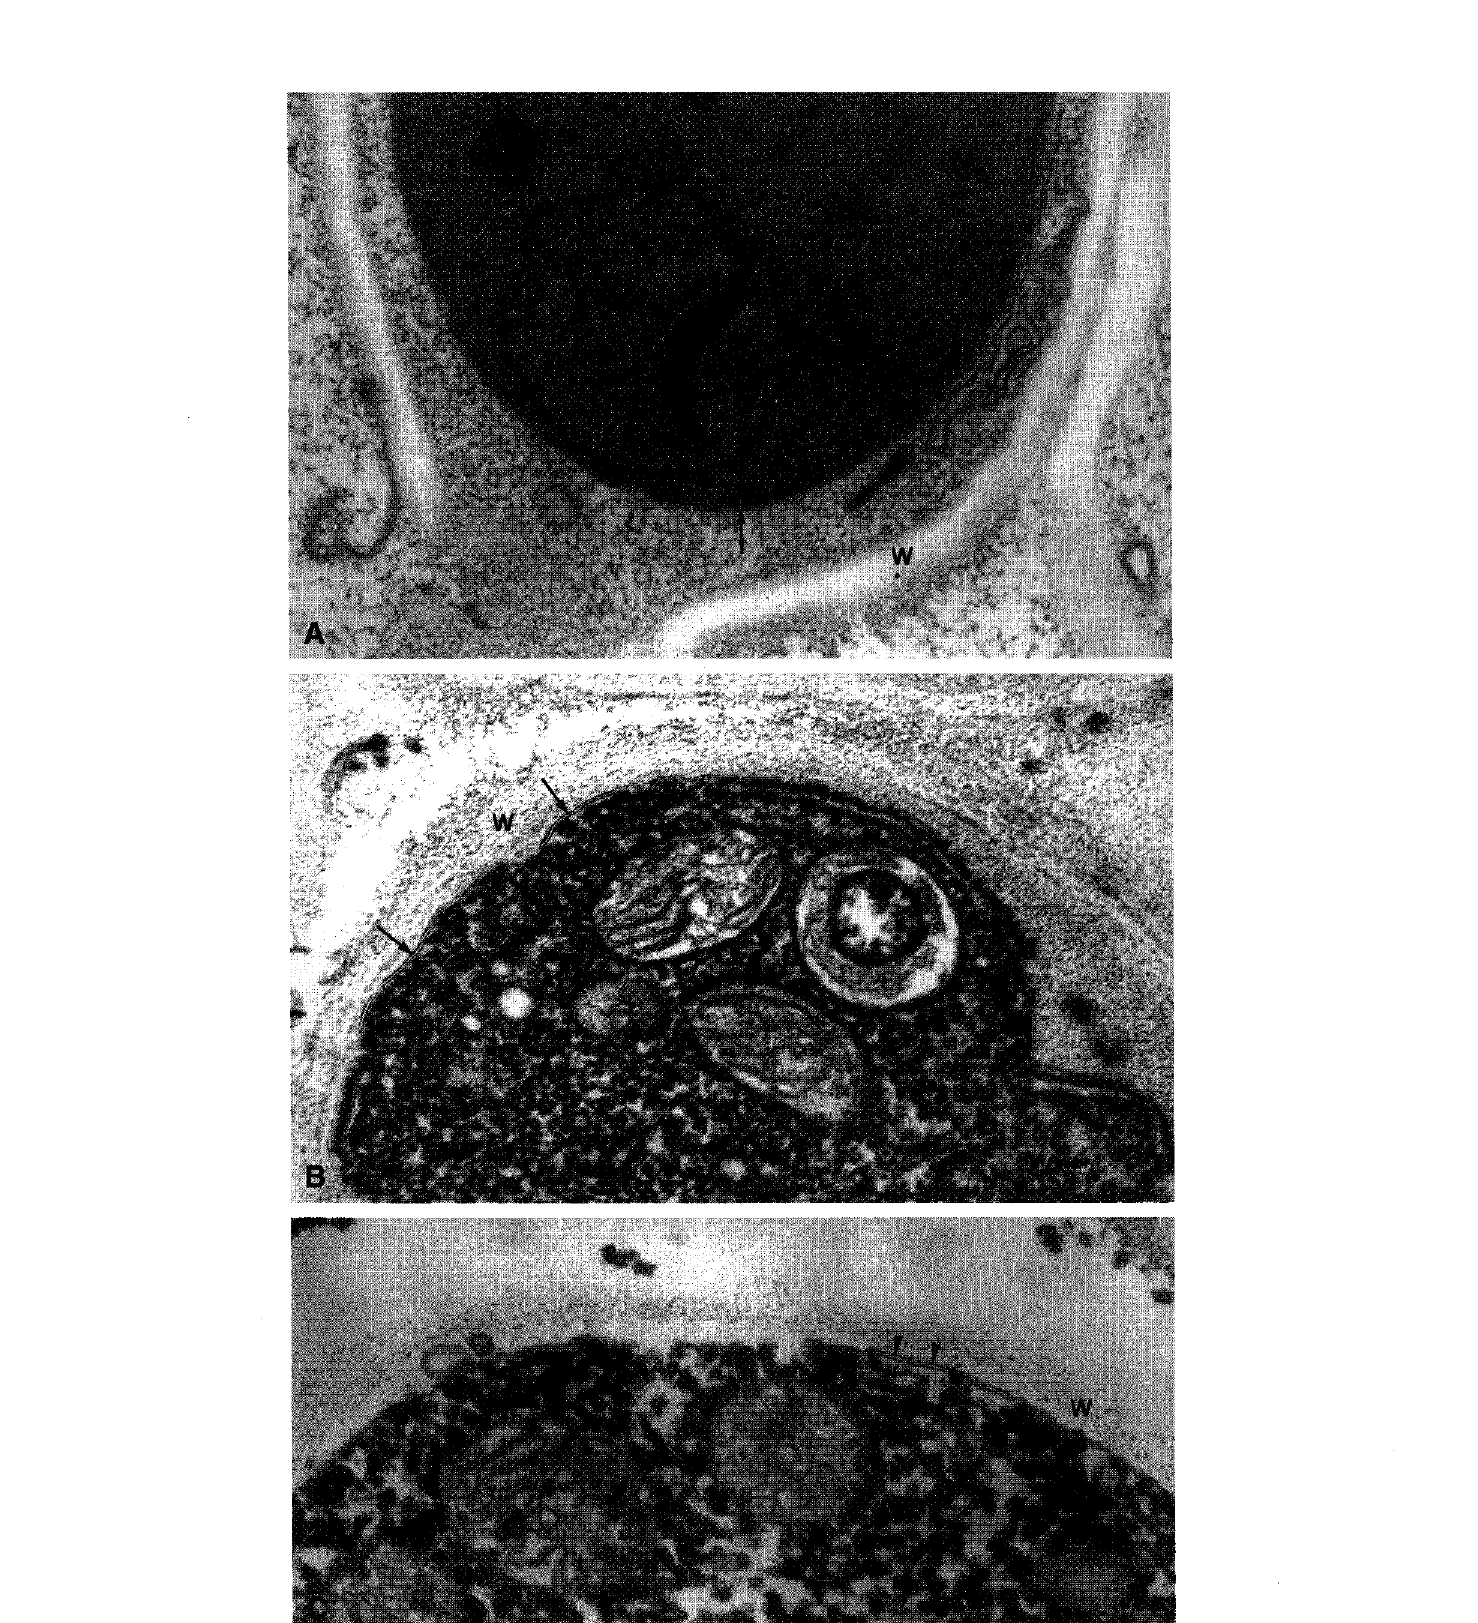
... High magnification of a spheroplast of control Fig. 7. cells showing the continuous, triple-layered cytoplasmic membrane (arrow). W, partially digested cell wall. Section stained with uranyl-lead. (x 72,000). I and C. Same condi- tions as in Fig. 7A but the spheroplast had been exposed to 0.3 mg/mL of benzydamine (B) or 30 mg/mL of lidocaine (C)